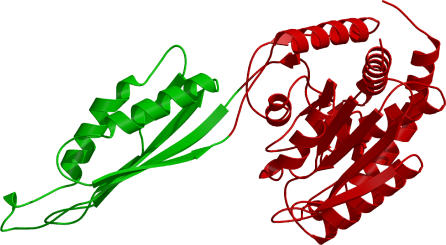
Example of a Multidomain Protein (PDB: 1cg2) Chain Containing a Discontiguous DomainDomain two (blue) is inserted between two segments of domain one (red).